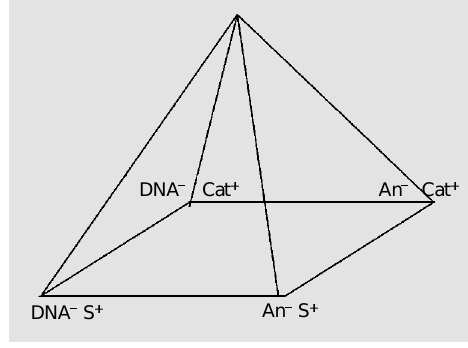
Figure 5. The end-to-end dis- tance is shown as a function of monomer charge for different valences of the counterions. No salt was added (N = 80, c m = 5.4 mM, and b = 6 Å). Reprinted from Ref. 25, with